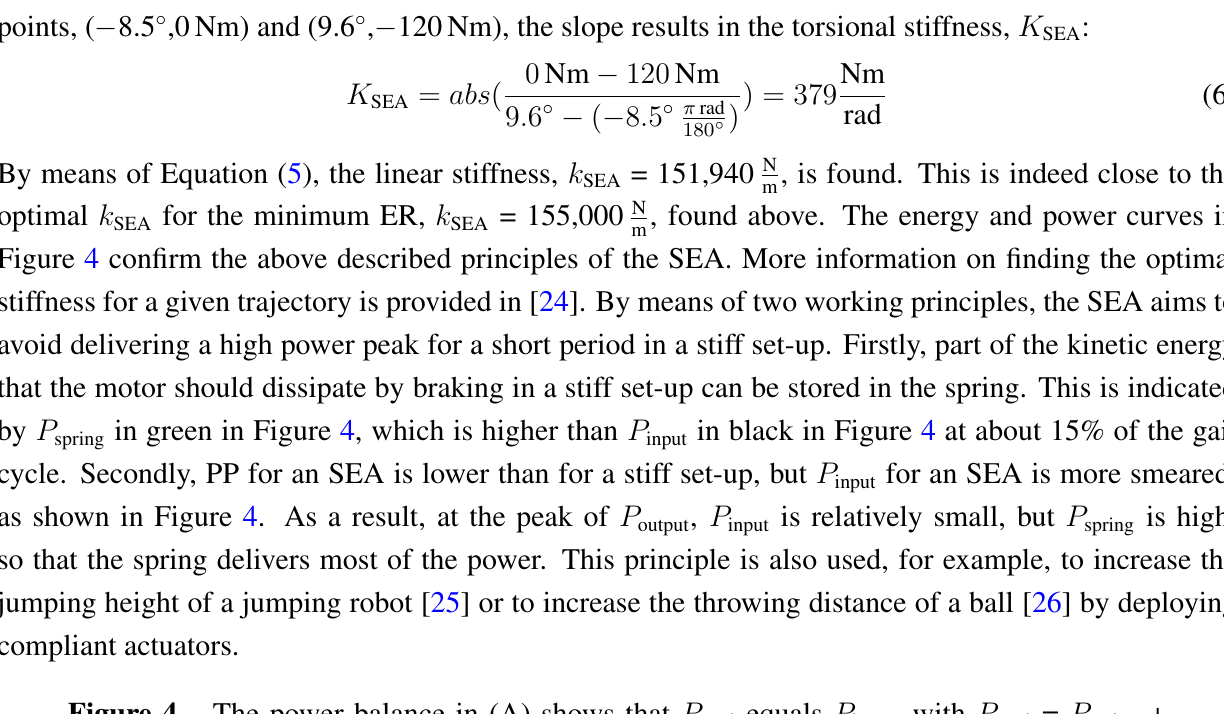
equals P , with P = P + total input total spring